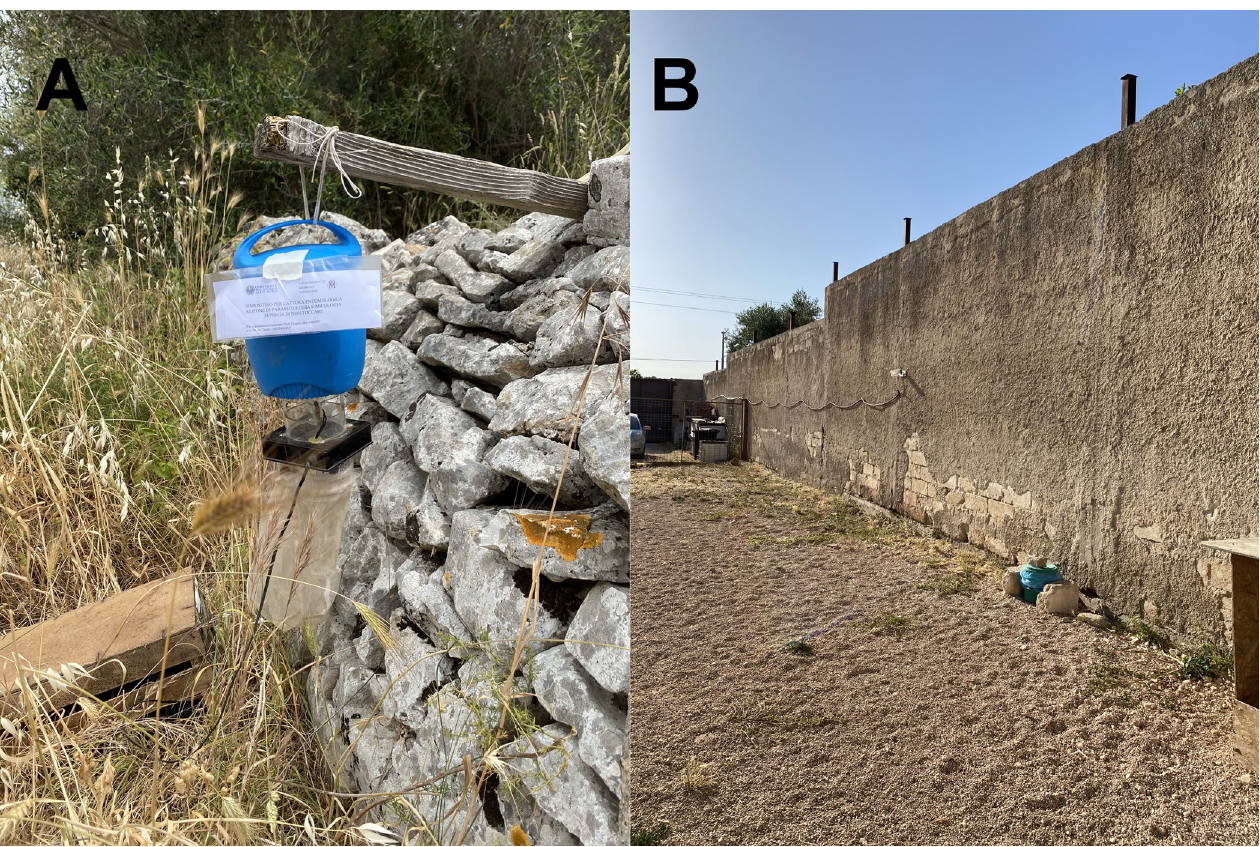
Fig 3. Environmental characteristics of both collection sites. A) “muretto a secco” where the CDC light traps were placed in the campus of Veterinary Medicine, University of Bari “Aldo Moro”. B) a high-walled private-owned dog